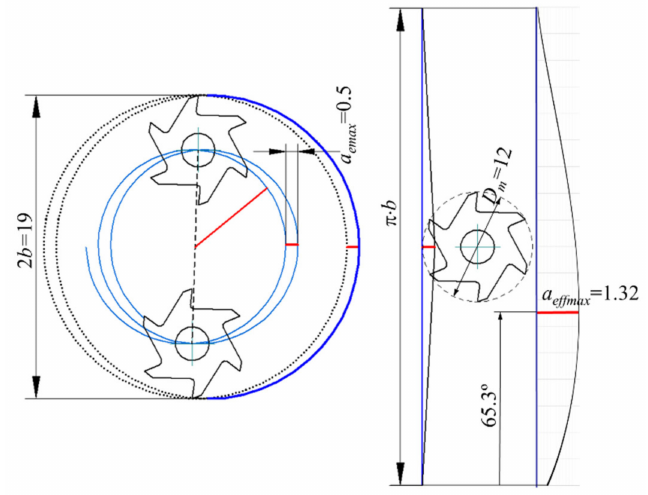
Figure 11. Equivalence between trochoidal and peripheral ramp milling with variable slope.